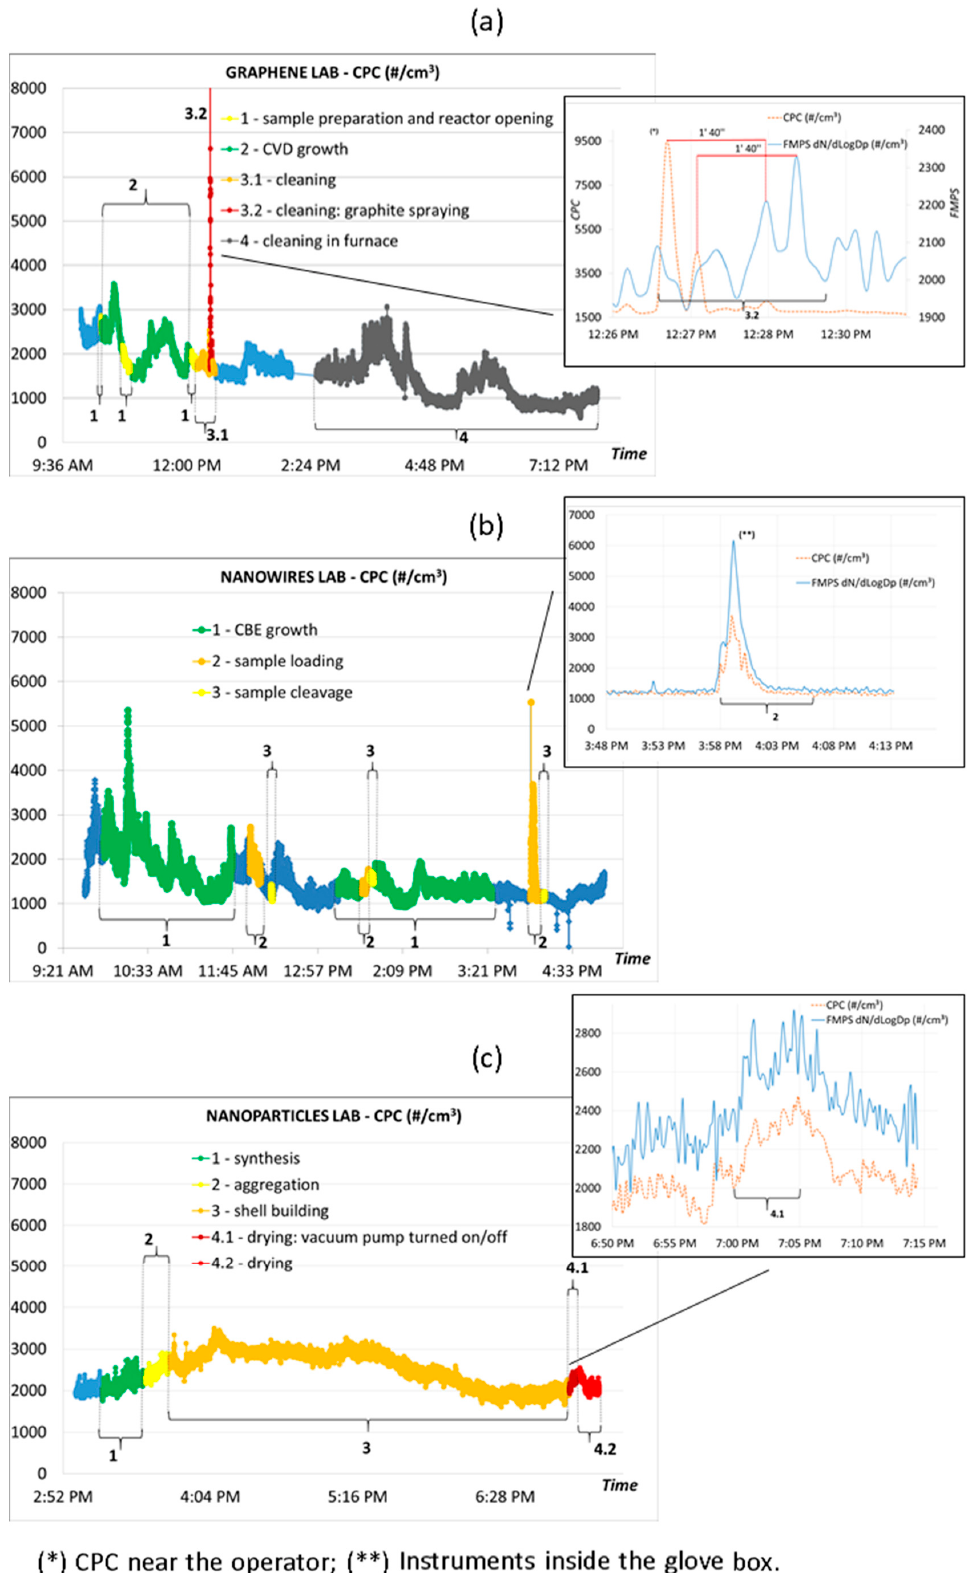
Figure 4. Time series of PNC (#/cm 3 ) measured by CPC in the G ( a ), NW ( b ) and NP ( c ) laboratories. The insets show the corresponding fast mobility particle sizer (FMPS) measurements.